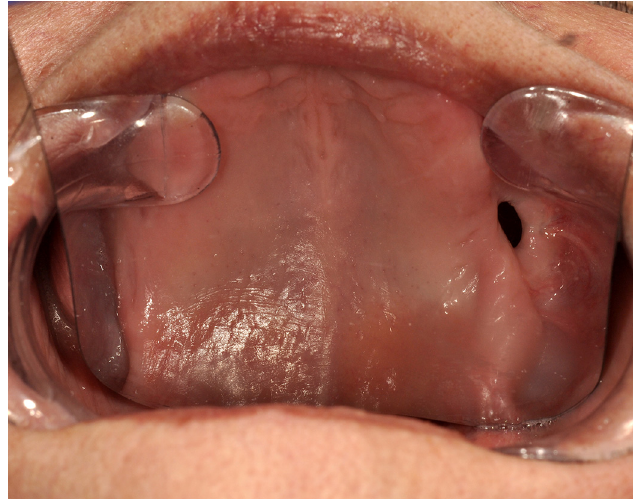
Fig. 1. Preoperative clinical photograph. Preoperative clinical photograph showing a 10 (cid:1) 4mm oroantral fi stula on the site of the tooth 26.